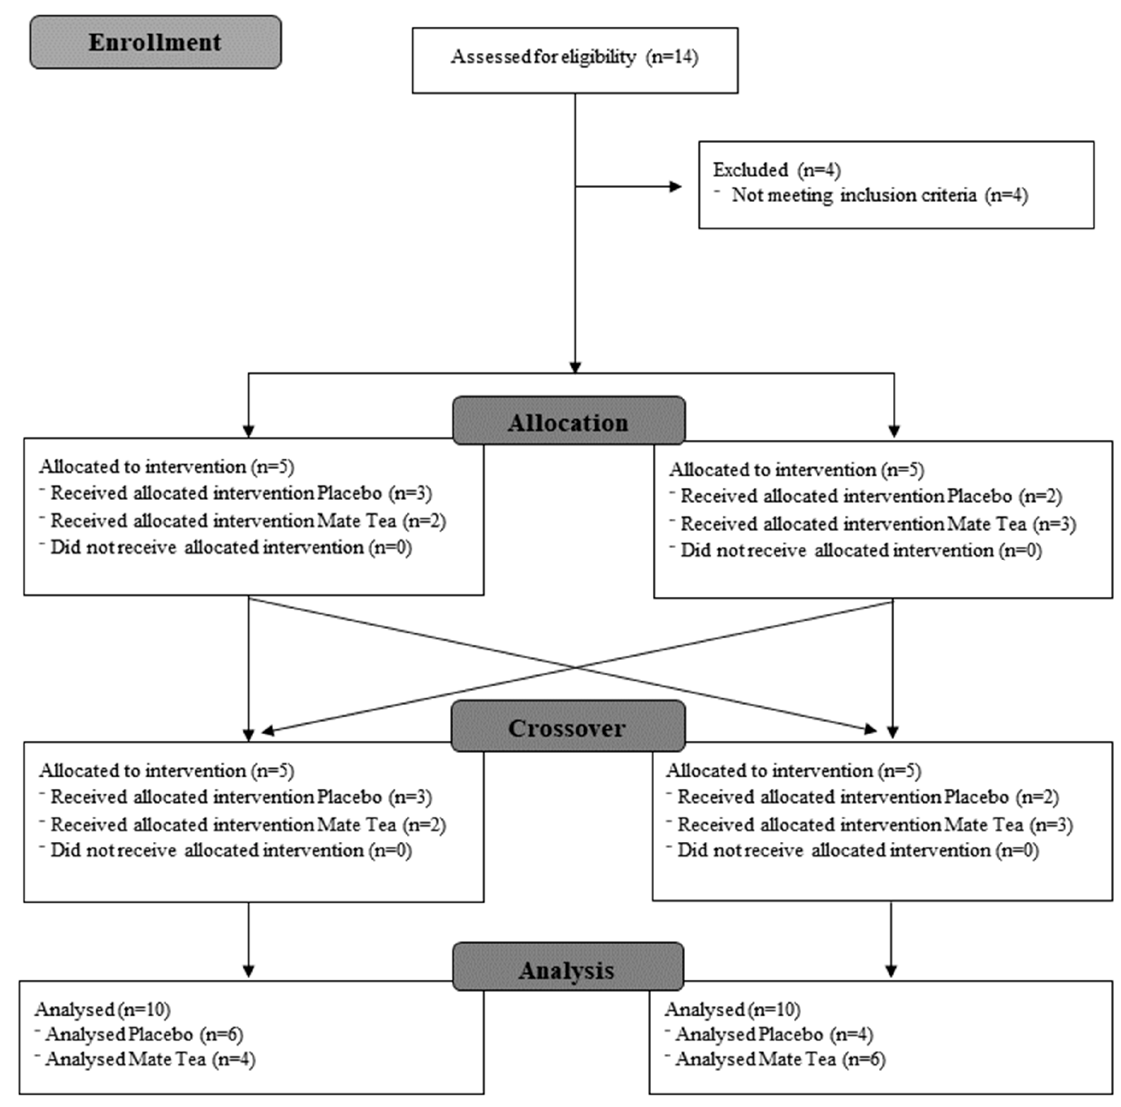
Figure 1. Study Figure 1. Study design.